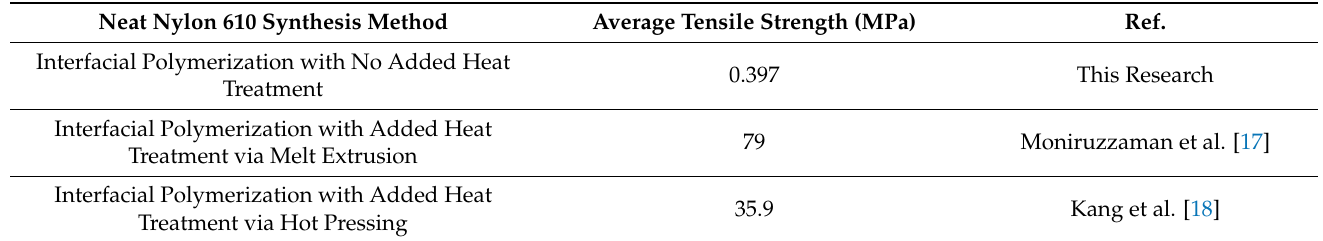
Table 2. Comparison Between the Neat Nylon 610 Synthesized in This Research and in Other